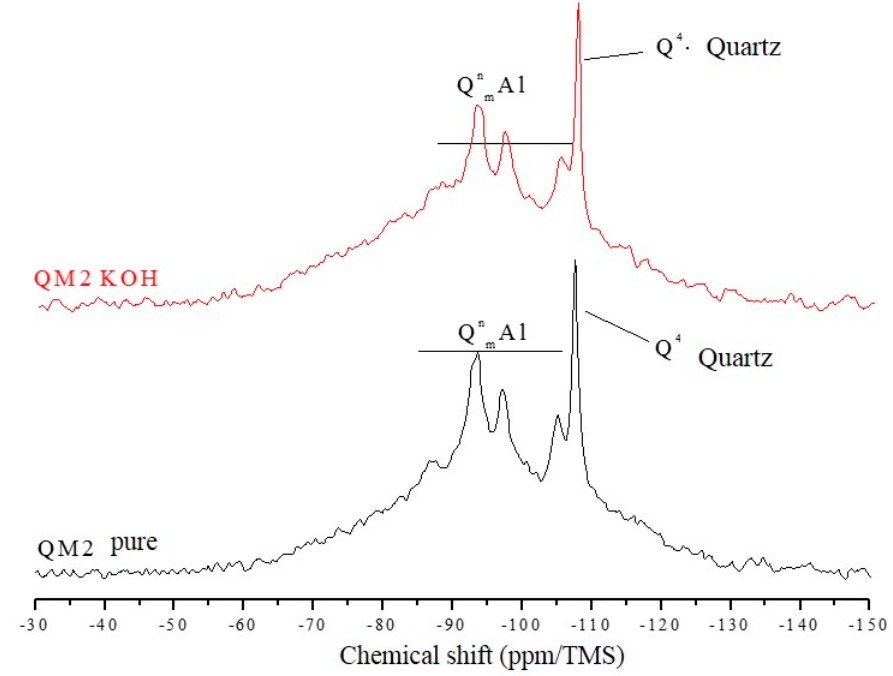
29 Si, of the QM2 sample. Materials 2018 , 11 , x FOR PEER REVIEW